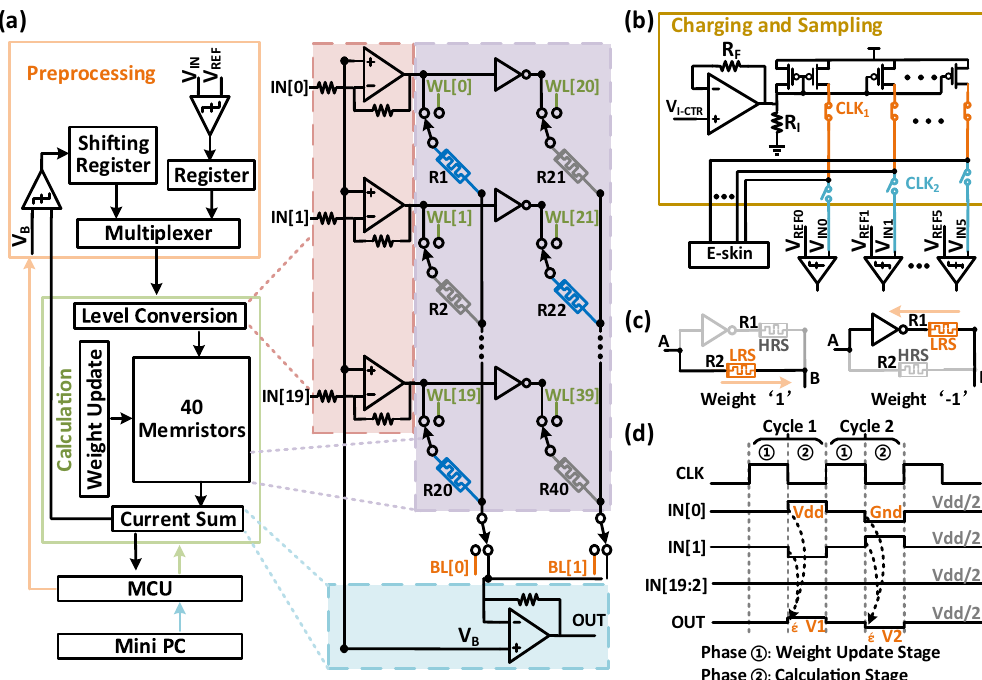
Figure 6. ( a ) Block diagram of the Braille recognition system based on the memristive neural network; ( b ) the circuit schematic of the charging and sampling module; ( c ) schematic of the circuit used to realize positive and negative weights; and ( d ) waveform diagram of the operation of the calculation